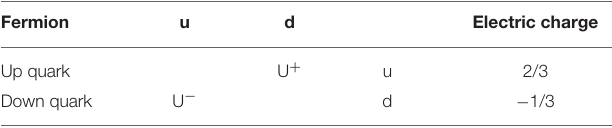
TABLE 1 | SU(4) representation for exchange of lepton with quarks by help of the colored X gauge boson. Fermion q r q g q b l Hypercharge Red quark G r X + r q r 1 / 3 g G r ¯ ¯ b Green quark G g X + g q g 1 / 3 r G g ¯ ¯ b Blue quark G b r ¯ Lepton